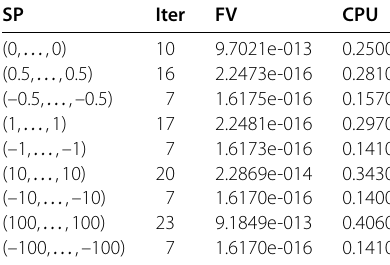
Table 2 Numerical results for Example 2 ( n =